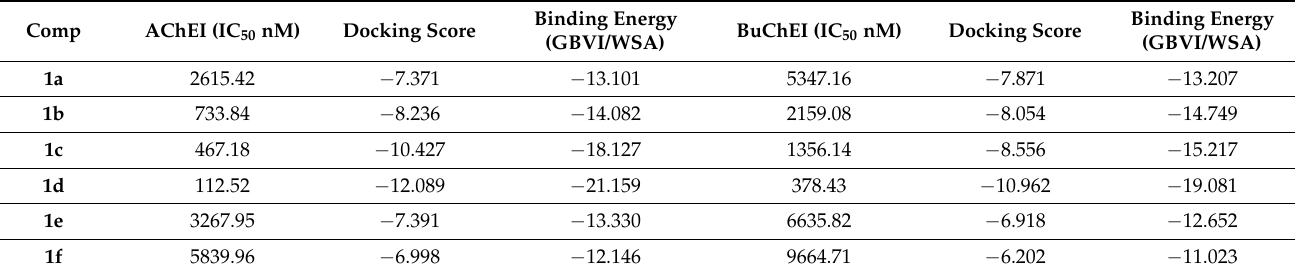
Table 2. The docking scores and binding energies of compounds ( 1a–1f ) of the calculated IC 50 values against AChE and